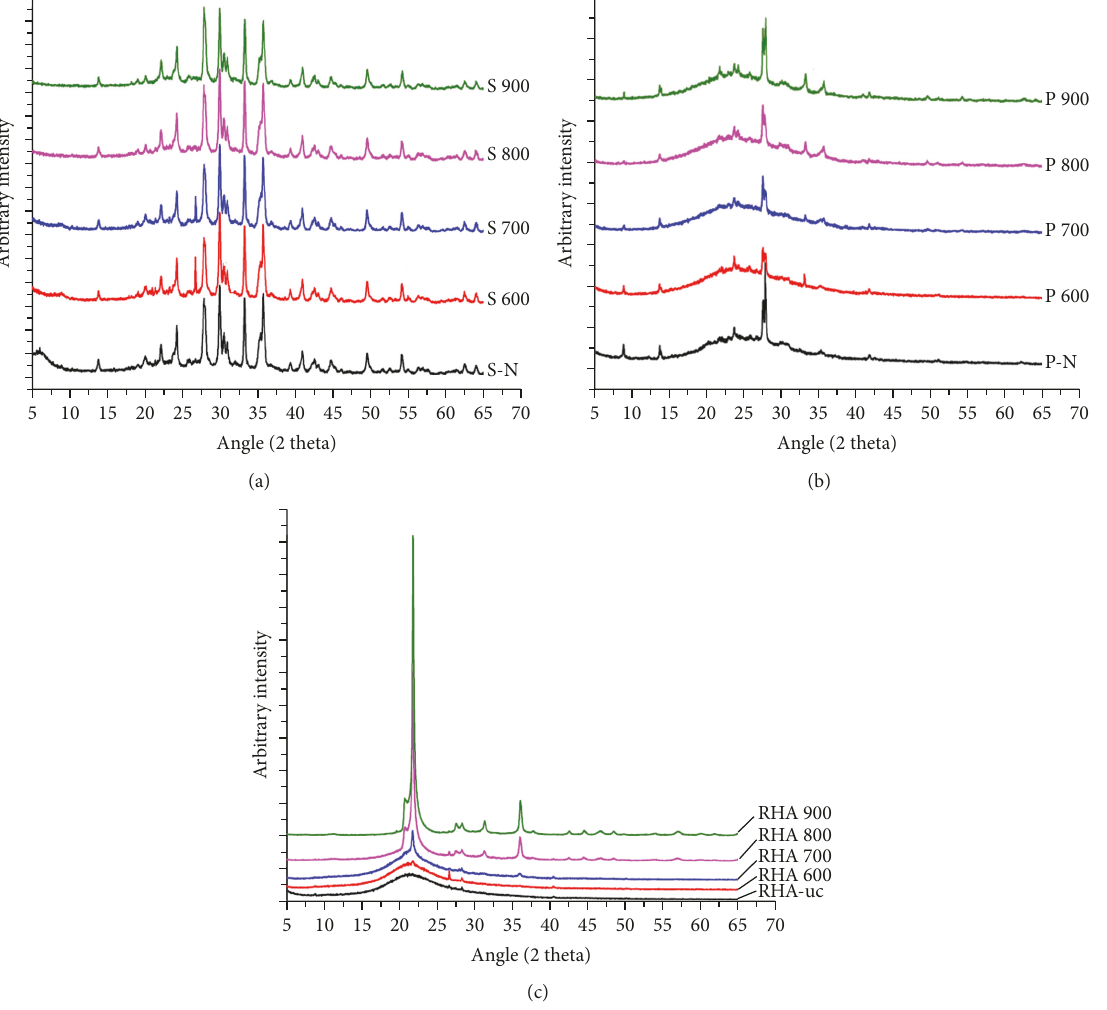
Figure 1: XRD patterns for (a) scoria, (b) pumice, and (c)